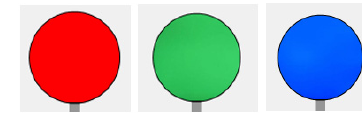
Figure 1. Simple visual tags.